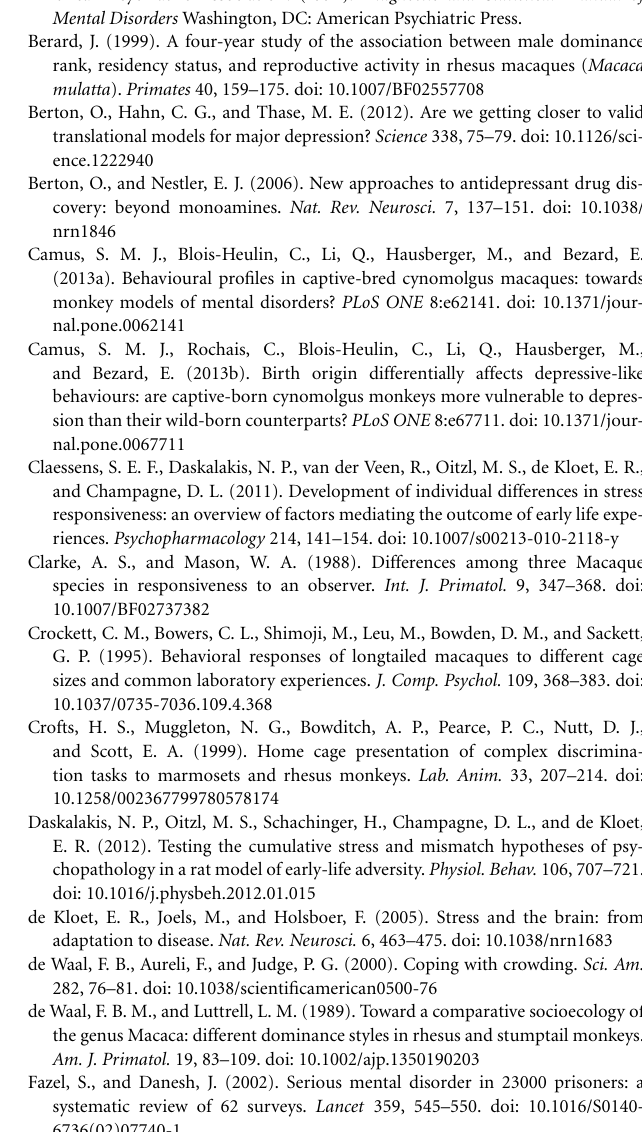
Figure S3| Dendrogram resulting from a hierarchical cluster analysis in socially-housed rhesus monkeys. Following the multiple component analysis, the coordinates of the 35 socially-housed rhesus monkeys were submitted to a hierarchical cluster analysis. The level indexes (above 0.10) are indicated on the dendrogram. One partition (blue arrow) resulted in 8 clusters for which the intra-cluster inertias are indicated on the right side of the graph. Animals from clusters 1, 4, and 7 (red font) expressed behavioral features similar to a few depressive symptoms whereas animals from the other clusters (green font) did